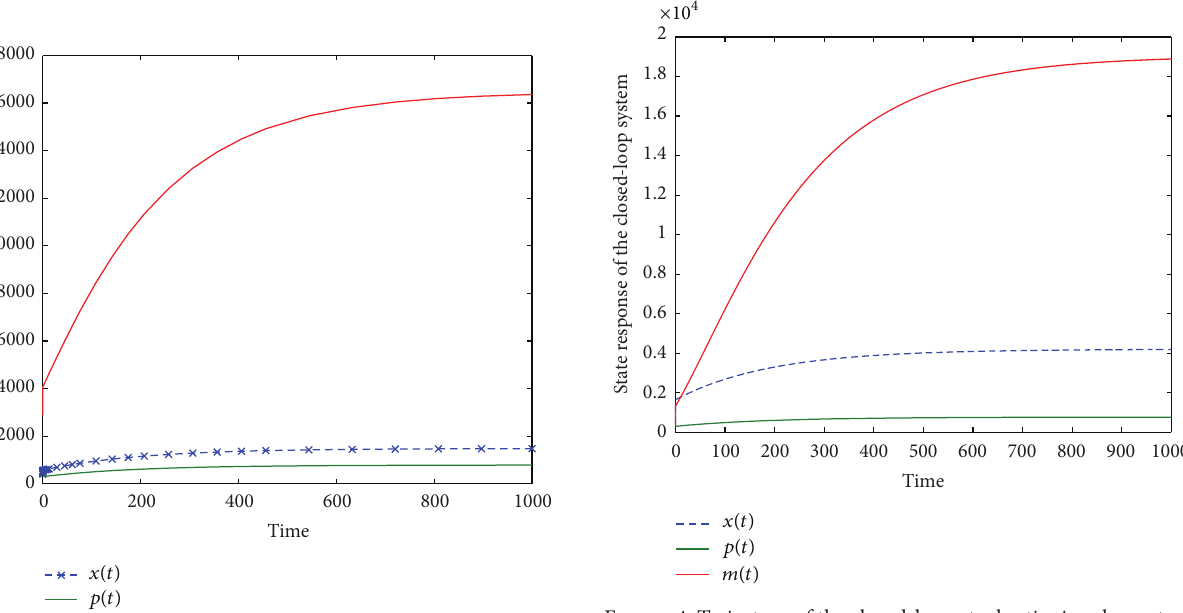
Figure 4: Trajectory of the closed-loop stochastic singular